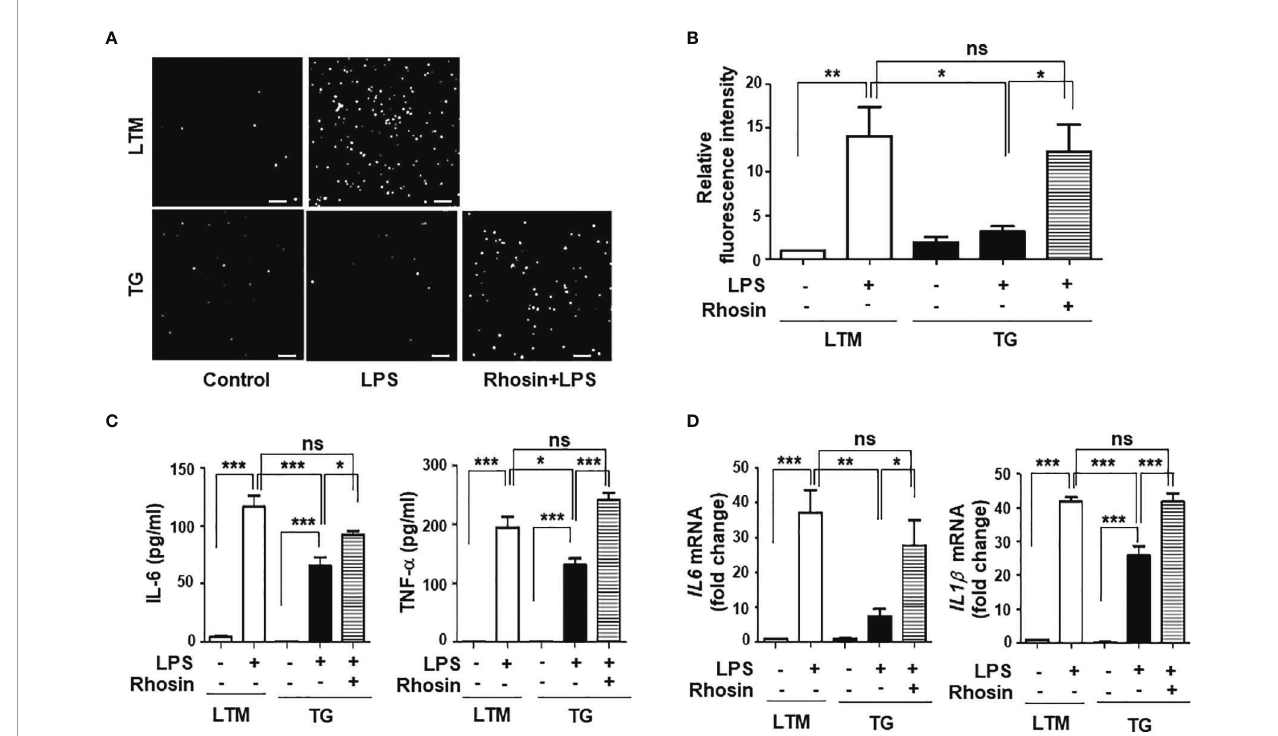
FIGURE 8 | Functional changes in p190RhoGEF TG macrophages caused by the inhibition of RhoA. TG PMs were pre-treated with an inhibitor of RhoA, rhosin (1 m M) for 1 hour. (A, B) LPS-mediated ROS production was compared as described in Figures 4A, B . Representative images (scale bars = 50 m m) (A) and the DCF fl uorescence intensity (B) of PMs from LTM and TG mice after a 30-minute stimulation with LPS (1 m g/ml) are shown. The data from three different experiments are presented as the mean ± SEM. Statistical signi fi cance was analyzed by one-way ANOVA with Tukey ’ s multiple comparison tests. Signi fi cant comparisons are noted as * p < 0.05, ** p < 0.01, ns, not signi fi cant. (C, D) PMs from LTM control and TG mice were incubated in medium alone (control) or with LPS (1 m g/ml) for 1 hour. The levels of IL-6 and TNF- a in the supernatants were compared by ELISA (C) . The data are the mean ± SEM of three independent experiments with triplet sample settings in each experiment. Statistical signi fi cance was analyzed by one-way ANOVA with Tukey ’ s multiple comparison tests. Signi fi cant comparisons are noted as * p < 0.05, *** p < 0.001, ns, not signi fi cant. Messenger RNA transcripts of IL-6 and IL-1 b were compared by quantitative real-time PCR analysis (D) . The relative level of expression is compared with the expression level in LTM control PM cells. Data are the mean ± SEM of three separate experiments. Statistical signi fi cance was analyzed by one-way ANOVA with Tukey ’ s multiple comparison tests. Signi fi cant comparisons are noted as * p < 0.05, ** p < 0.01, *** p < 0.001, ns, not signi fi